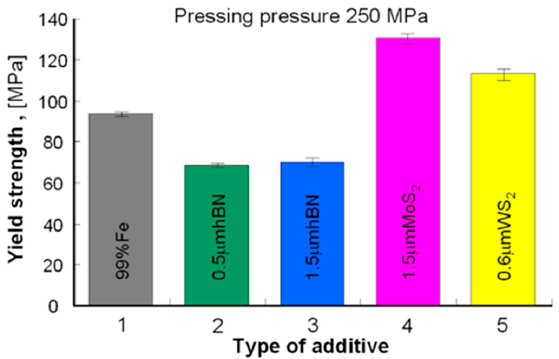
Figure 7. Results of compression measurements of sintered samples pressed under the pressure of 250 MPa.